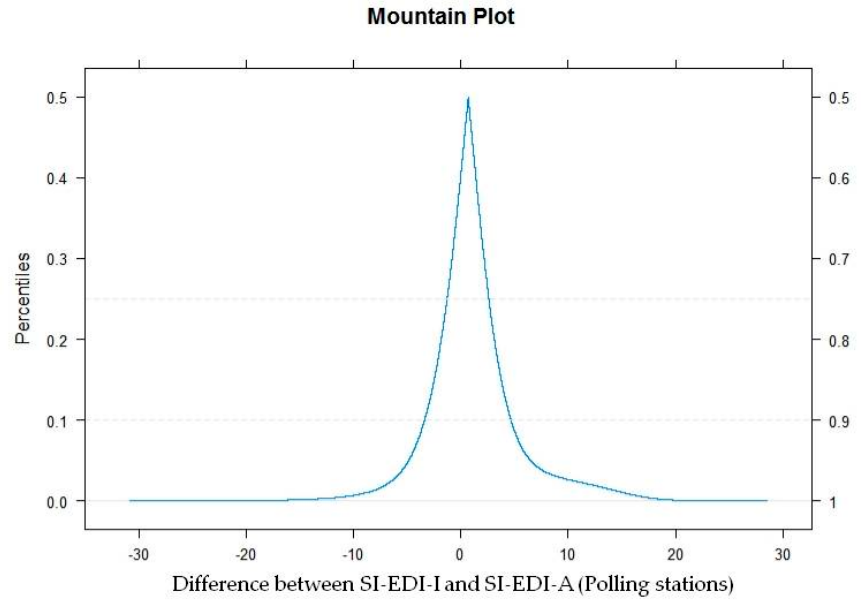
Figure 3. Mountain plot.